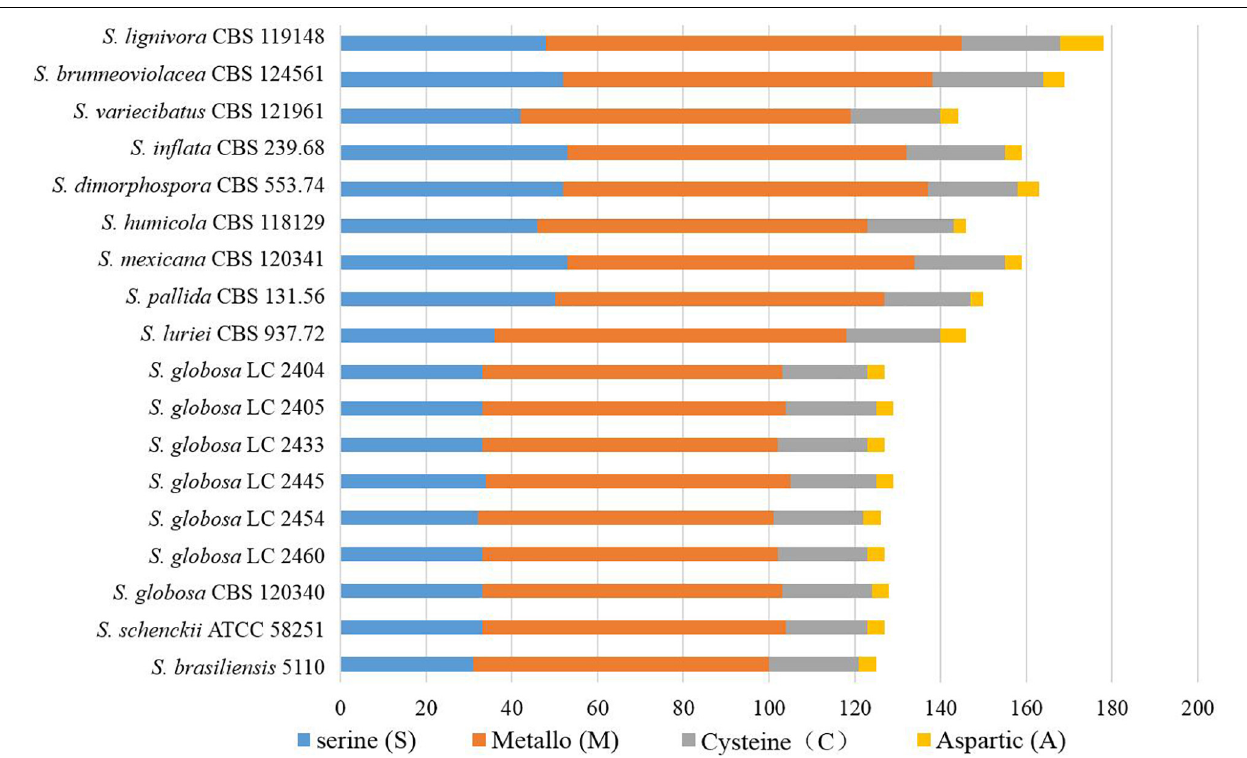
Frontiers in Microbiology |